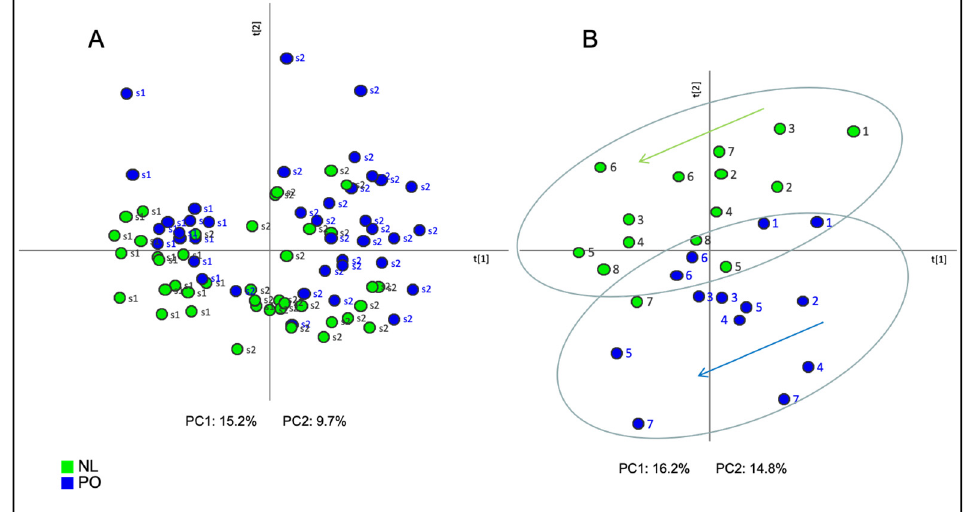
Figure 1 . Score plot of the Principal Component Analysis (PCA) based on the whole array of the mass spectra within a m/z range from 35 to 220 obtained from samples of Clemenules (NL: green) and Clemenpons (PO: blue) collected during ( A ) both season 1 (s1) and season 2 (s2); ( B ) during s1; numbers 1 to 7 account for harvest day, from earlier (1) to later date (7). Only for NL variety, the later date in s1 was date (8). PC1: first principal component; PC2: second principal component.